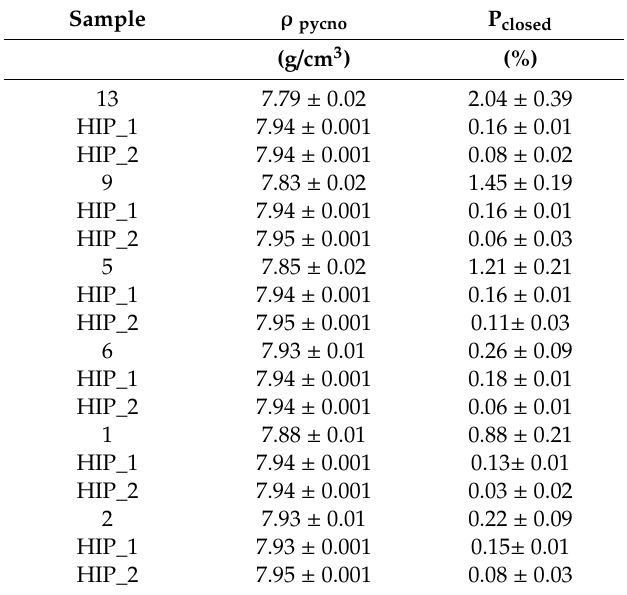
Table 5. Determined porosity levels in the samples after SLM and SLM + HIP_1 and SLM + HIP_2 (porosity of samples after the HIP_2 process is determined on the basis of one measurement of rectangular samples and three measurements of cylindrical samples, a total of